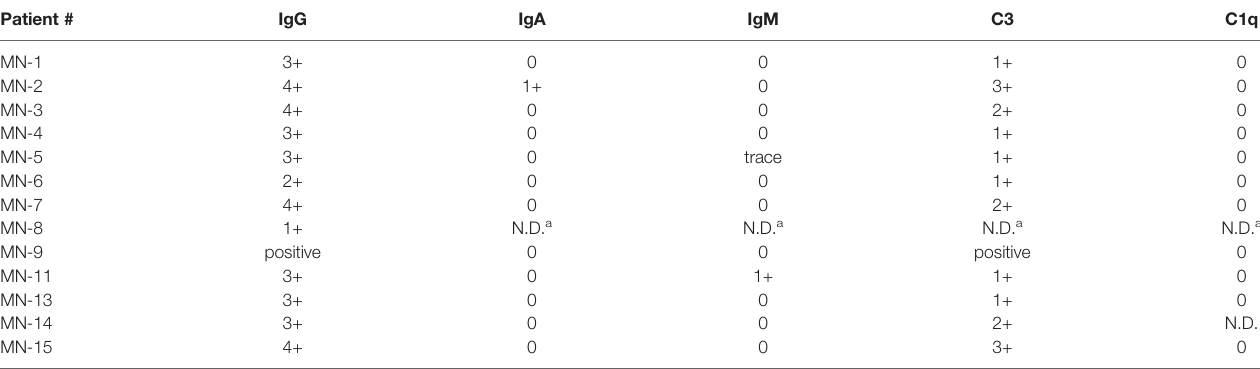
TABLE 2 | The results of immuno fl uorescence staining in the MN renal biopsies. Patient